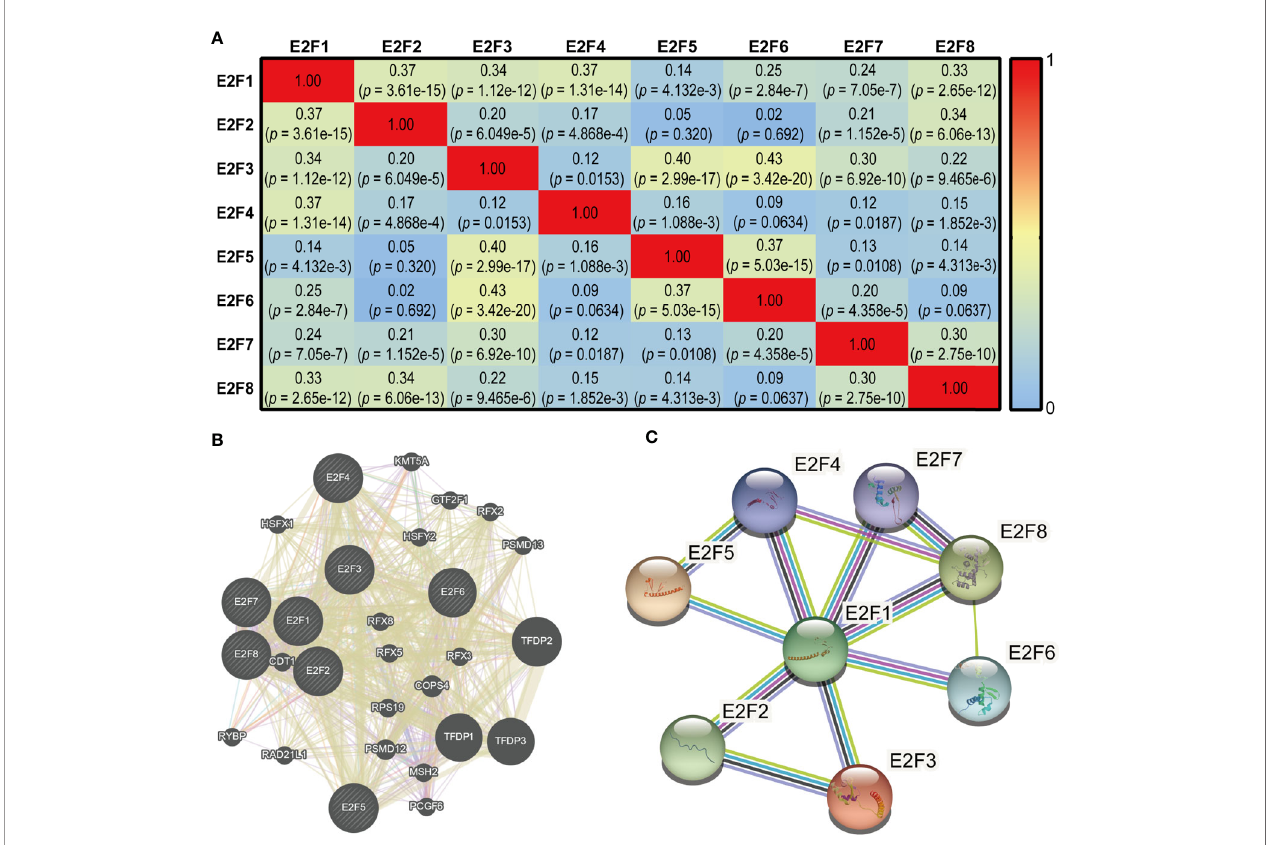
FIGURE 9 | Co-expression and interaction analysis of E2Fs at gene and protein levels in STAD patients (cBioPortal, GeneMANIA and STRING). (A) Pearson correlation analysis of expression of E2Fs predicted by the cBioPortal. (B) Gene-gene interaction network among E2Fs predicted by the GeneMANIA. (C) Protein- protein interaction network among E2Fs predicted by the